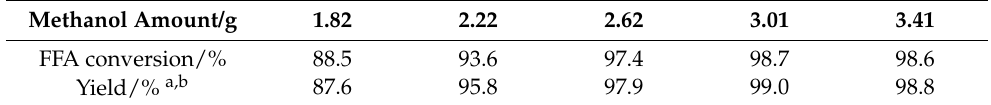
Table 2. The influence of the amount of methanol on the reaction.